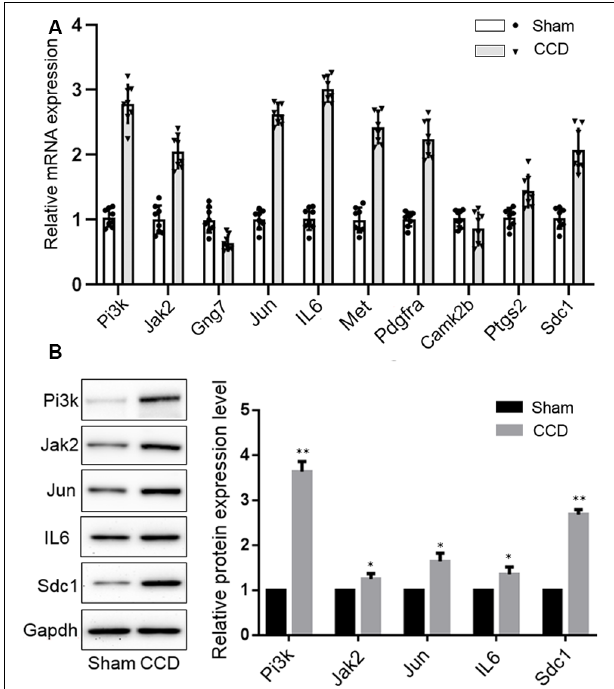
FIGURE 6 | Experimental validation of key genes. (A) Reverse-transcription quantitative chain reaction was performed to detect the mRNA expression of 10 key genes. (B) Western blotting validation of the protein expression changes of key genes in the CCD and sham group. Gapdh was used as a loading control. ∗ p < 0.05 and ∗∗ p < 0.01 compared with the sham